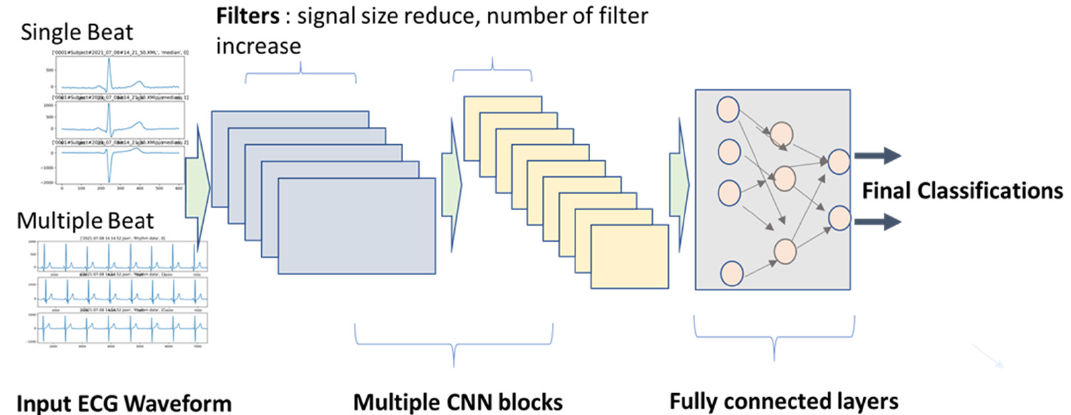
Figure 6. A diagram of CNN model for AECG classifications. The model input can be a single beat or multiple beats. Multiple ECG leads can form an ECG image. If only 1 lead is presented, then 1-D CNN can be used. However, if there are multiple leads as inputs, 2-D CNN can be used. There are multiple CNN blocks to form a deep layer structure. Usually, the number of filters is gradually increased, but the size of the output of each block is reduced by down-sampling after each block of max/average pooling and stride operation. The final block of the model consists of fully connected layers. The final output can be either binary or multiple classifications.